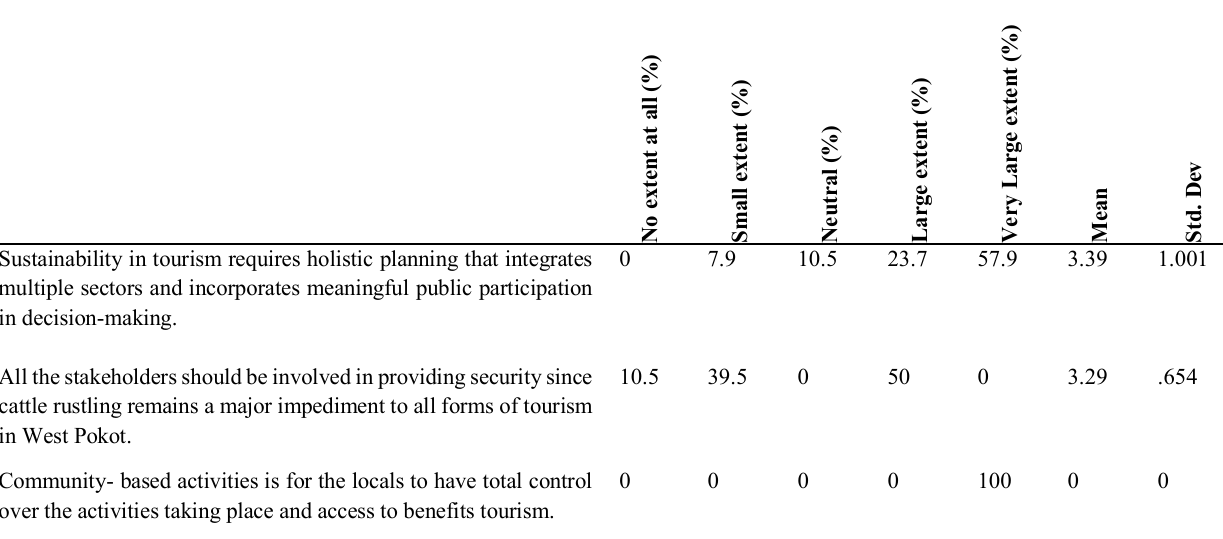
Table 1: Influence of stakeholders’ participation on tourism